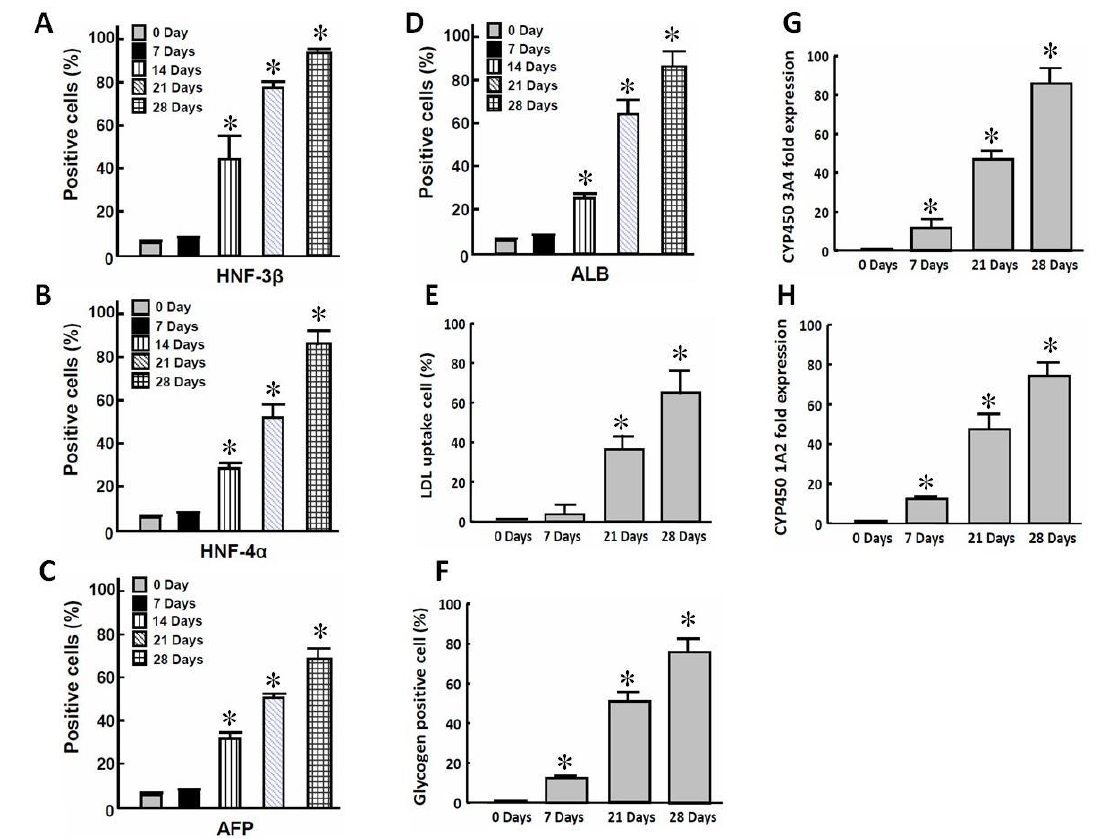
Figure 2. Recruitment of hepatocyte-specific markers, biological functions and enzyme activities. ( A – D ) Detection of hepatocyte-specific proteins using immunofluorescence. Immunostaining imaging (800×) results showed several hepatocyte-specific markers, including HNF-3β,  FP, ALB, and HNF-4α; ( E ) The uptake of Low-Density Lipoprotein (LDL) was measured by the incorporation rate of DiI-Ac-LDL and ( F ) the presence of stored glycogen was determined by PAS staining. The relative activities of ( G ) cytochrome P enzyme CYP3A4 and ( H ) CYP1A2 were analyzed by a commercial ELISA kit. Data 450 shown here are the mean ± SD of three independent experiments. In panels A–H; * P < 0.05 vs . undifferentiated iPSCs at Day